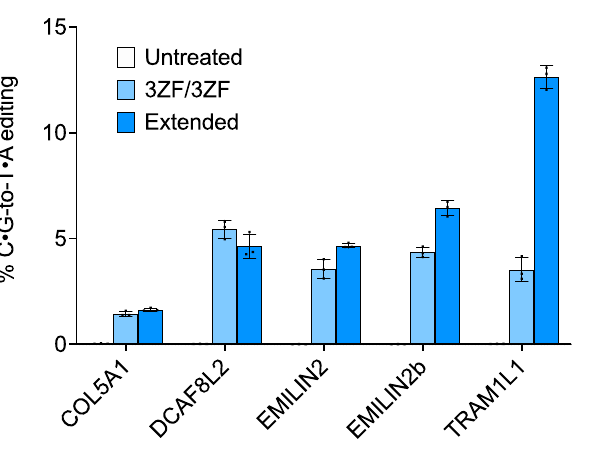
ef fi ciencies of HEK293T-HBB cells treated with an optimized ZF-DdCBE pair designedtocorrectthe HBB − 28A>Gmutation.TheDNAspacingregion,splitDddA orientation, ZF array lengths, and ZF-targeted DNA strands (LT left top, RB right bottom) are shown, and the pathogenic cytosine is colored in blue. For ( a and b ), values and errors re fl ect the mean±s.d. of n =3 indepe n dent biological replicates. Source data are provided as a Source Data fi